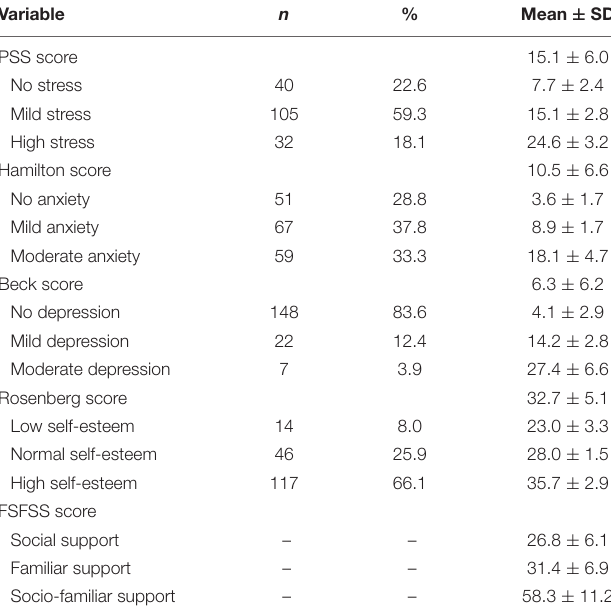
TABLE 2 | Psychometrics of the participants ( n =